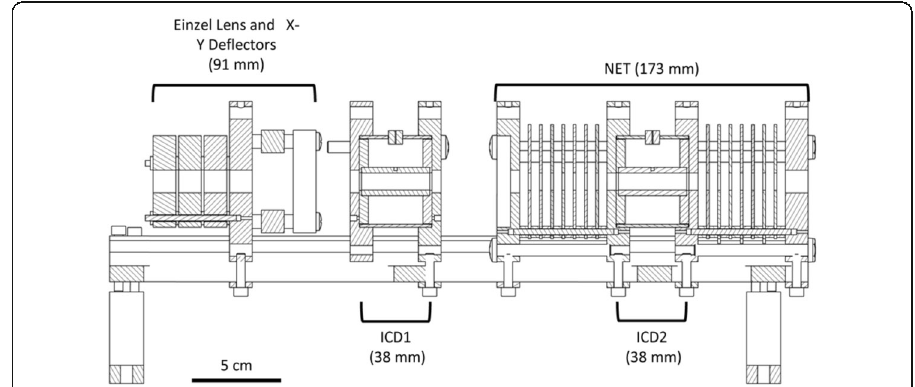
Fig. 2 Schematic of the NET assembly. The electrostatic optical elements are mounted on alumina rails to allow isolation of each